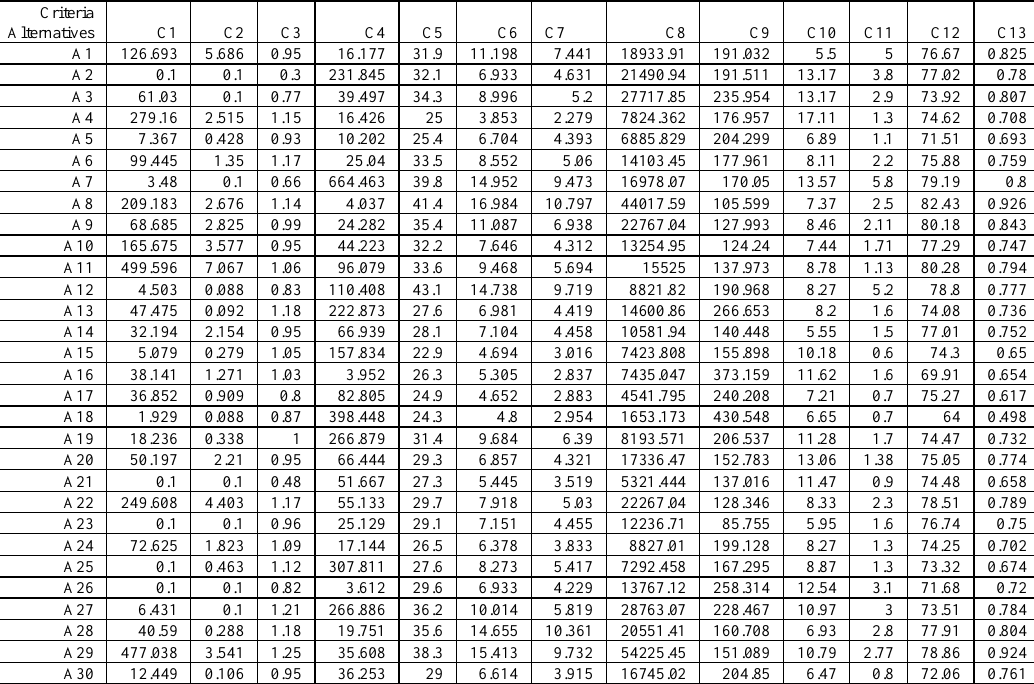
Table 2. Decision Matrix for information as on 30 th November